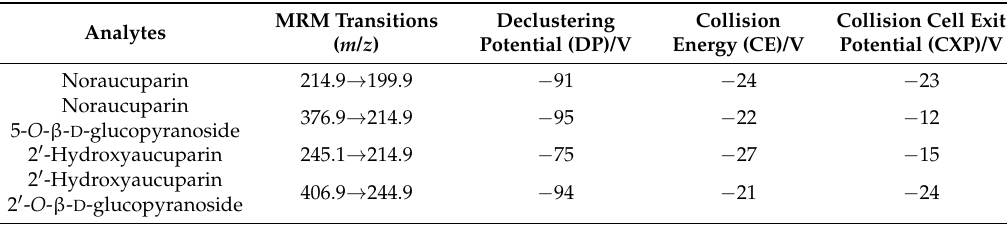
Table 3. MS analysis on parameters of nine